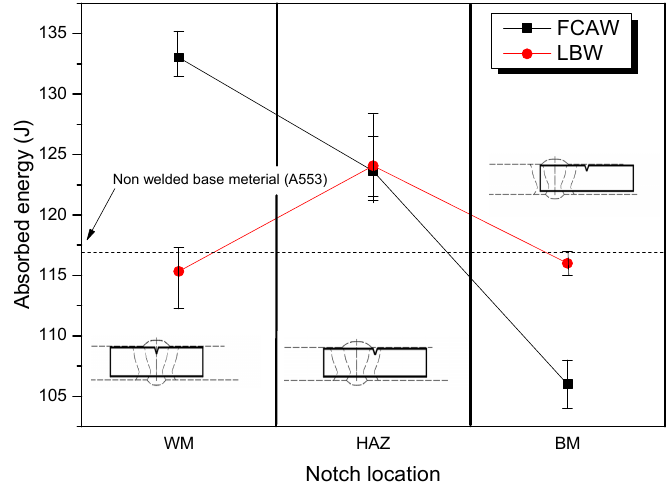
Figure 12. Comparison of LBW and FCAW impact-absorption energy by notch position